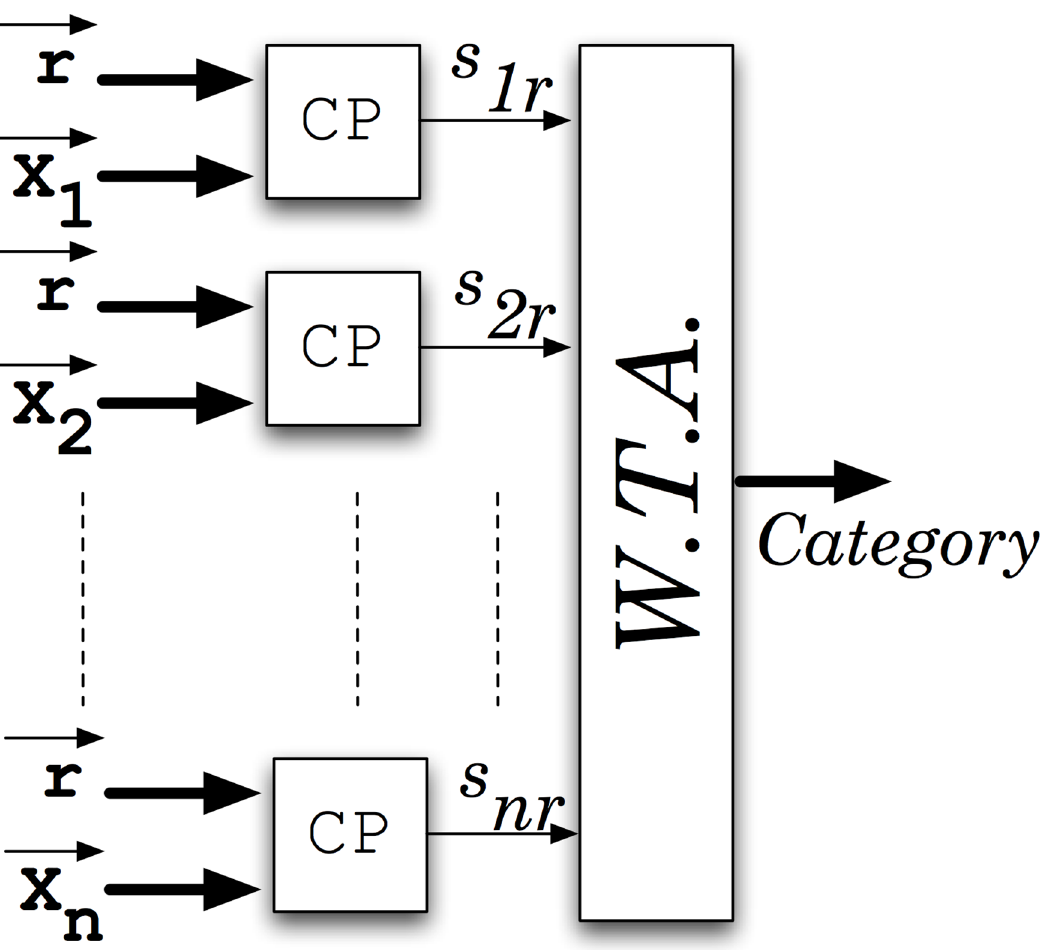
Fig 8. Architecture used to estimate the closest category to the reference vector 'r'. Each comparator (CP) provides at its output a switching signal proportional to the similarity of the two vectors connected to it. The Winner-Take All selects the highest frequency signal.